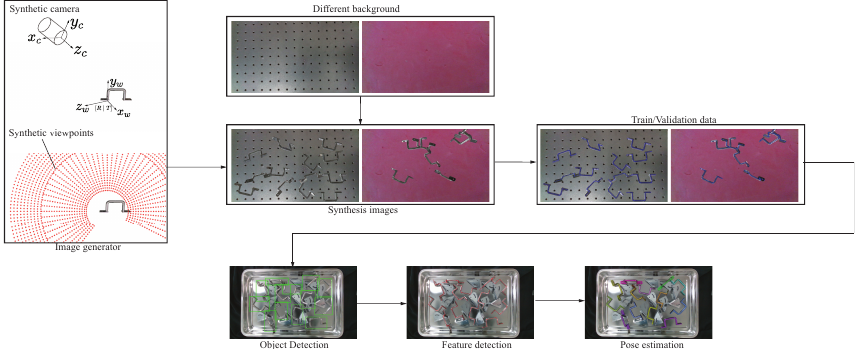
Figure 2. Flowchart for constructing a pose estimation